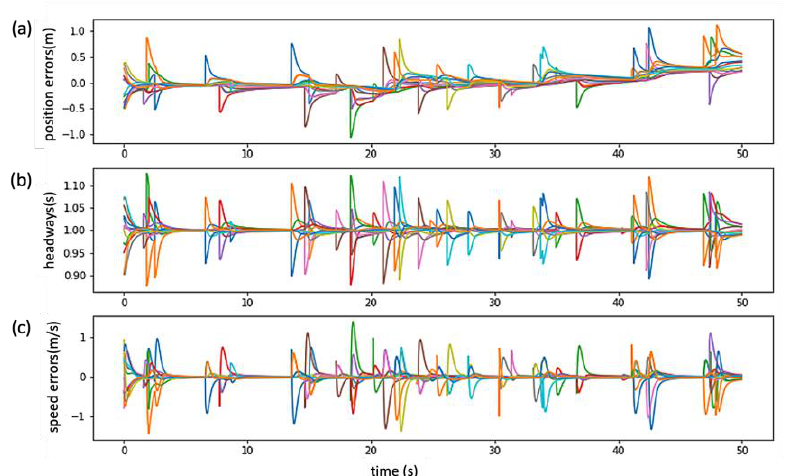
Figure 7. Stability and safety analysis of virtual platoon control: ( a ) position errors; ( b ) headways; ( c ) speed errors.